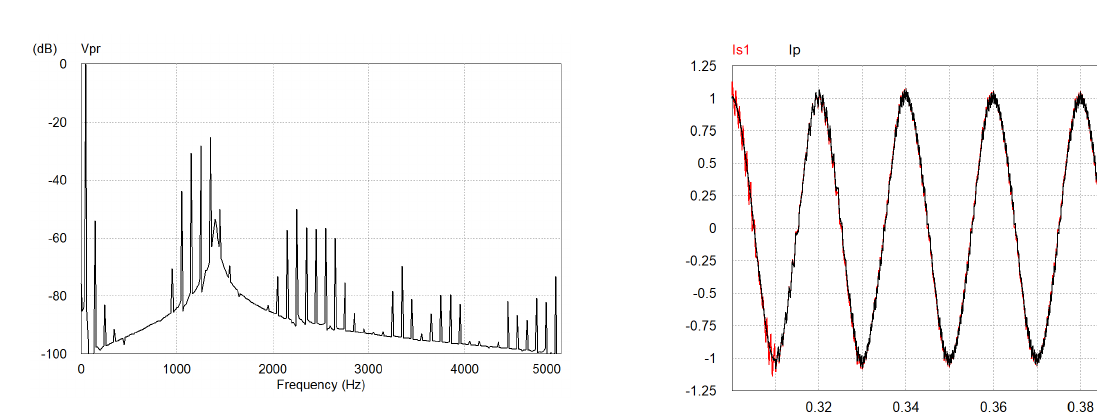
Figure 19. Frequency spectrum of the primary voltage (Vpr), showing resonance conditions.